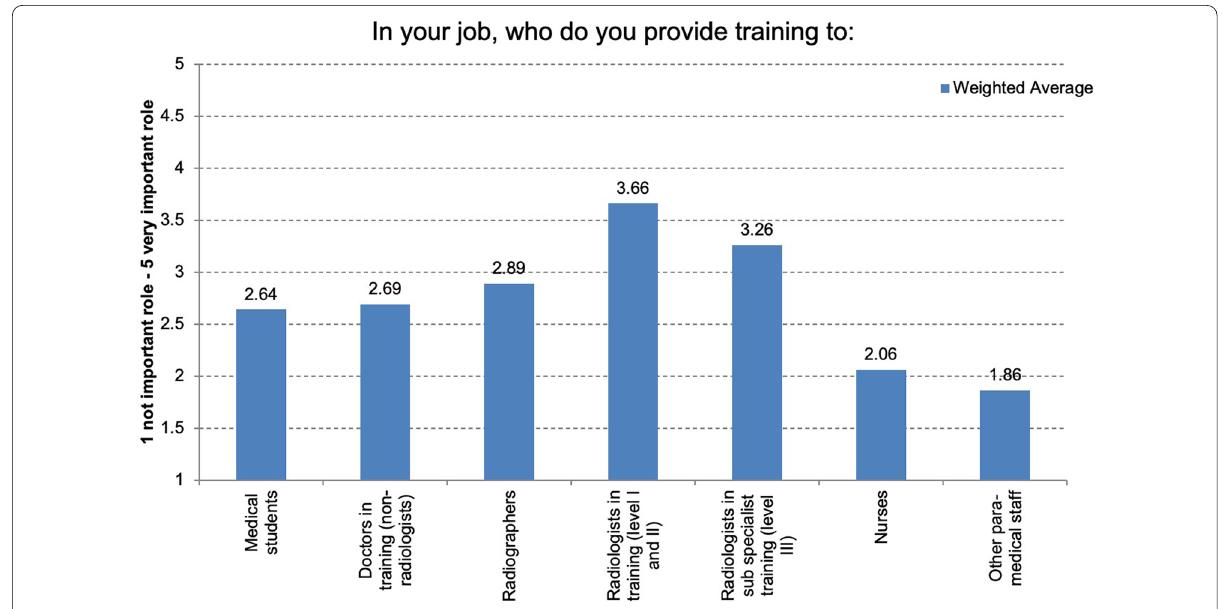
Fig. 14 In your job, who do you provide training to: (responses n